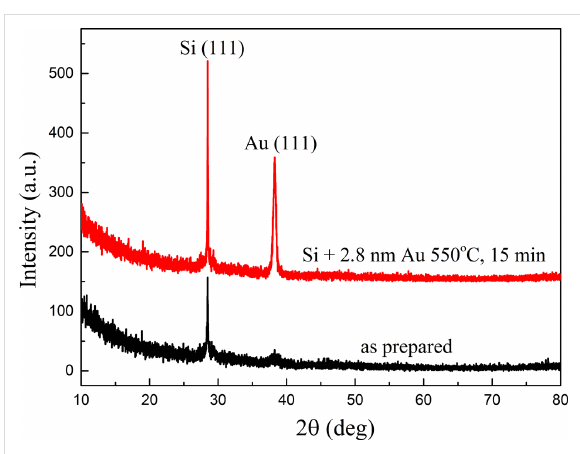
Figure 7: XRD result of a 2.8 nm Au film annealed at 550 °C for 15 min and an as-prepared 2.8 nm Au film on Si(111) substrates.